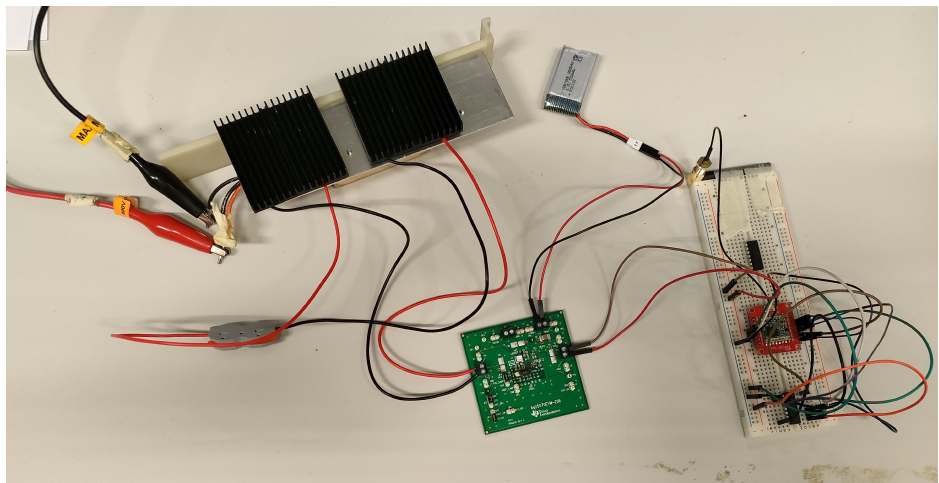
Figure 13. Final set-up with the two TEGs in series. The wireless node, the Li-Po battery and the evaluation node are also